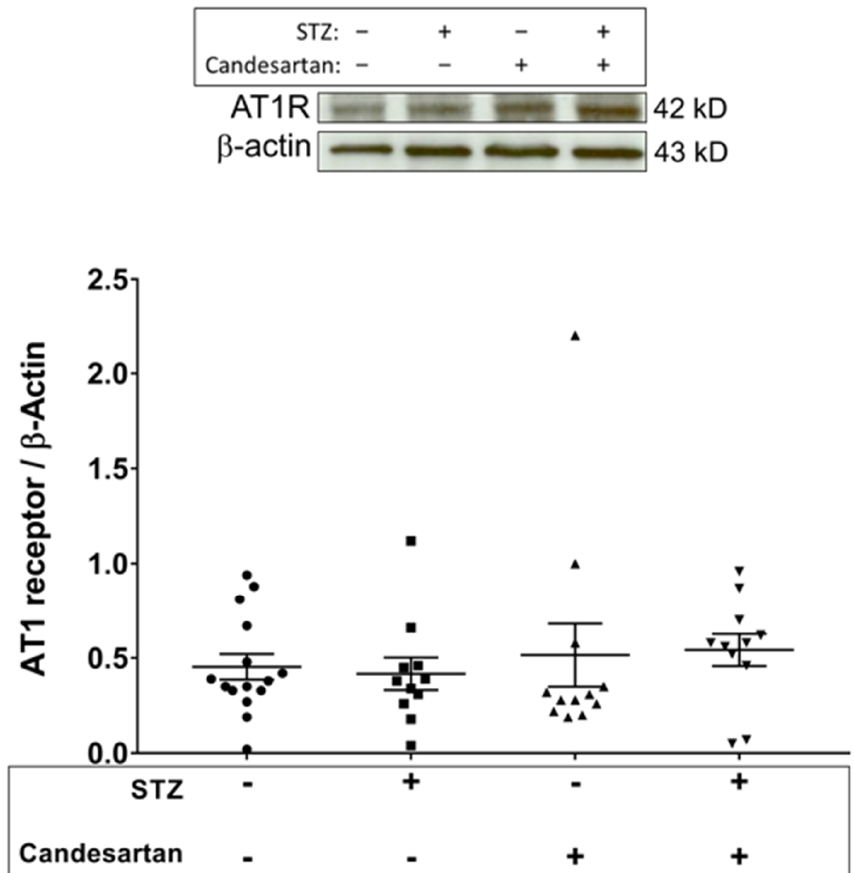
Figure 4. Retinal tissue protein levels (Western blot data; normalized to β-actin) of the angiotensin II type 1 receptor (AT1) in the four groups of rats: untreated non-diabetic controls, untreated STZ, candesartan-treated non-diabetic controls, and candesartan-treated STZ. No statistical differences were found between groups. N = 11–15 per group.